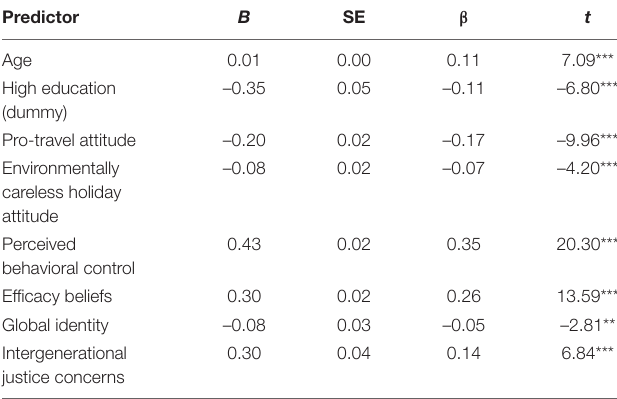
TABLE 6 | Results of linear multiple regression of intentions to avoid